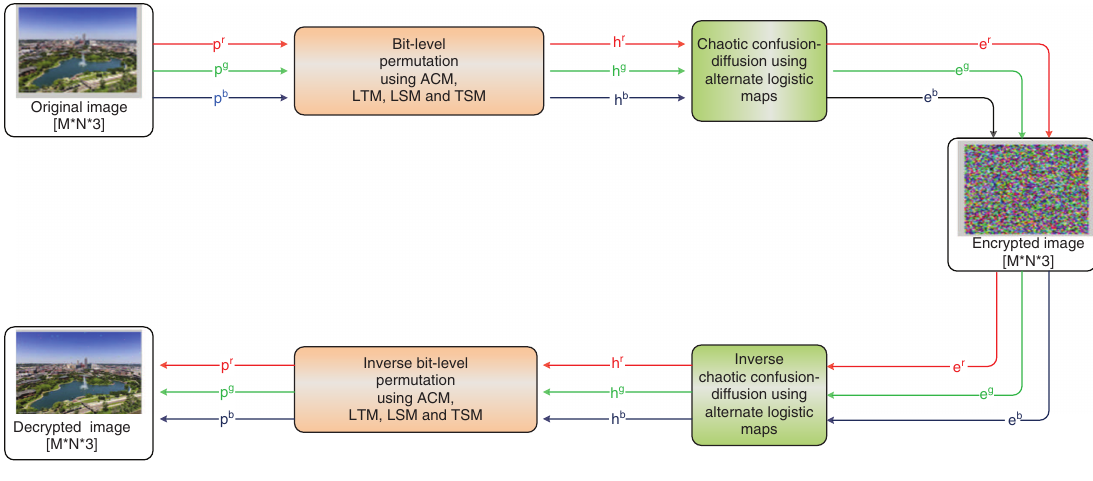
Figure 1: Block Diagram for Encyrption-Decryption